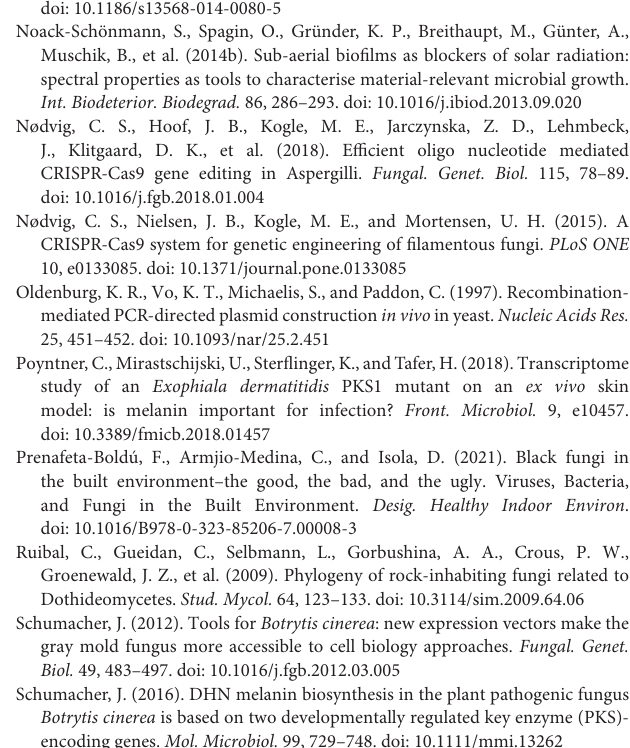
Botrytis cinerea is based on two developmentally regulated key enzyme (PKS)- encoding genes. Mol. Microbiol. 99, 729–748. doi: 10.1111/mmi.13262